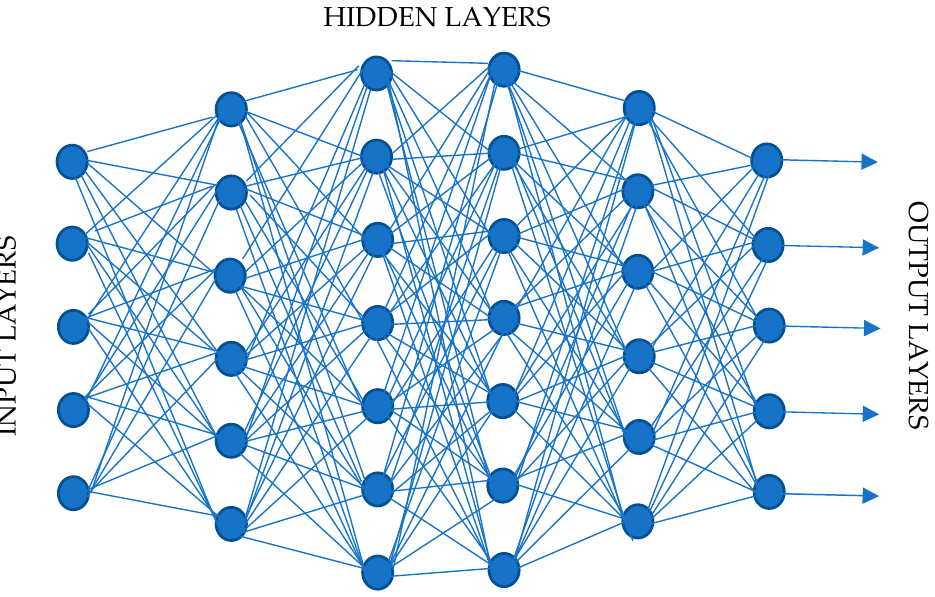
Figure 2. A representation of a neural network [1] .